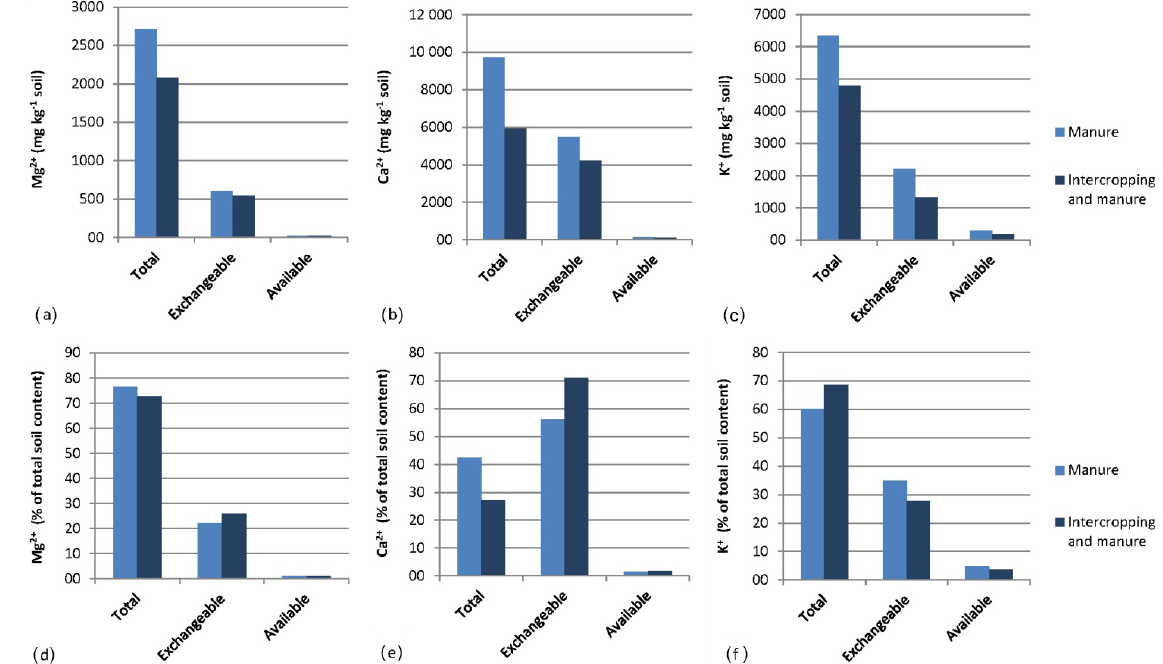
Figure 1. (a, b, c) Bars length show the total, exchangeable, and plant available / water-soluble amount of Mg, Ca, and K (in mgkg − 1 ) soil under management practices of manure and intercropping and manure. (d, e, f) Total, exchangeable, and plant available / water-soluble Mg, Ca, and K in the soil as percentage of the sum.